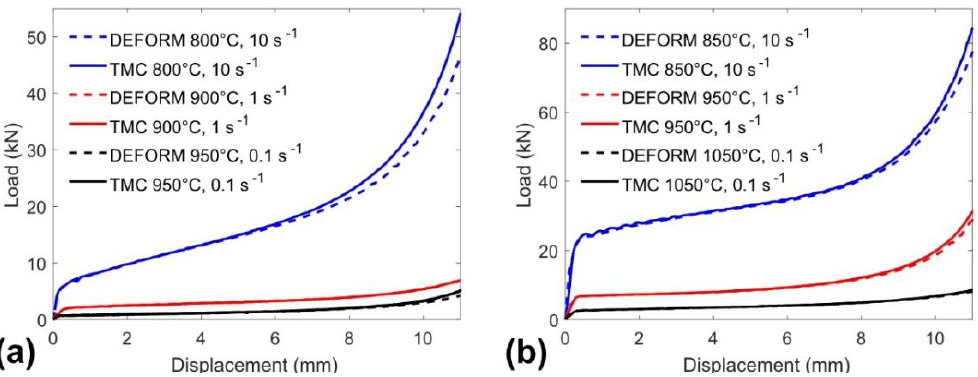
Figure 6. Friction corrected load displacement curves comparing experimental TMC and FE simulations for; ( a ) CP-Ti alloy material post FAST consolidation; and ( b ) Ti-6-4 alloy material post FAST consolidation.